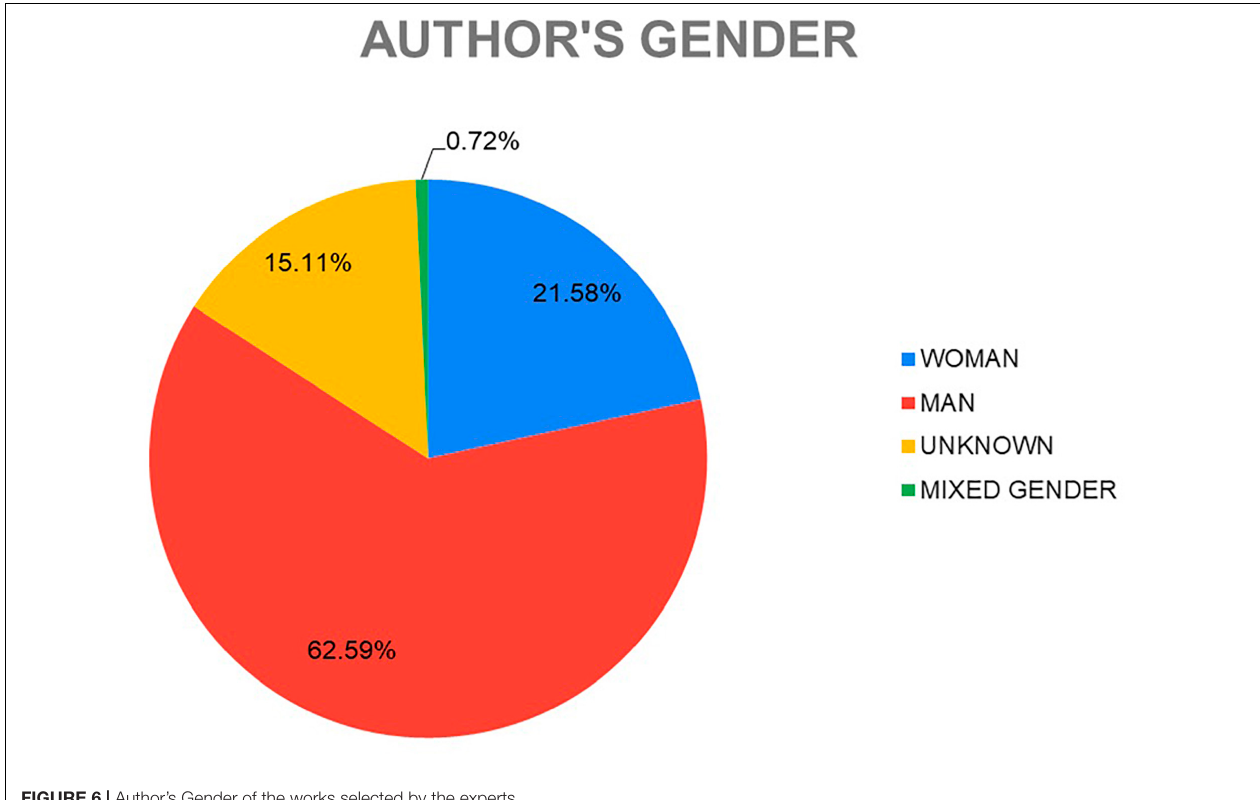
FIGURE 6 | Author’s Gender of the works selected by the experts.